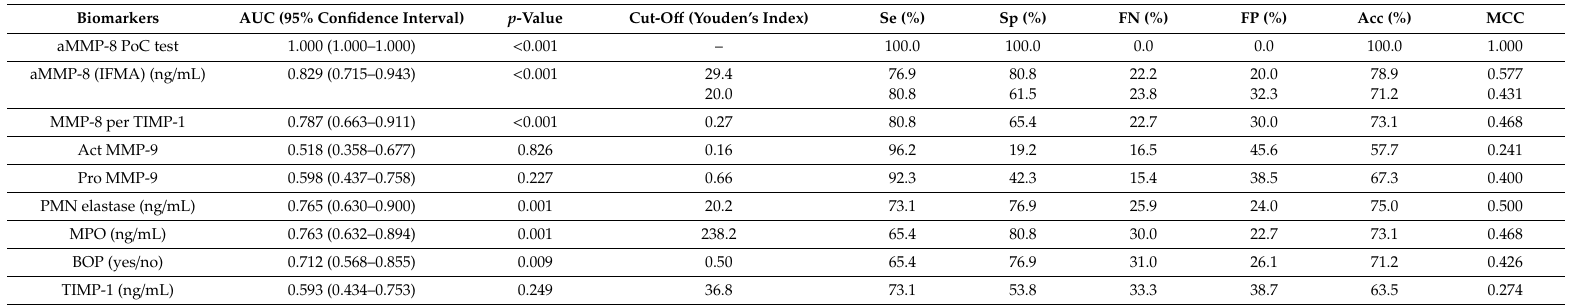
Table 3. Receiver operating characteristic (ROC) analysis and the area under the ROC curve (AUC) illustrating the diagnostic ability of the biomarker candidates to discriminate peri-implantitis from a healthy implant (26 peri-implant and 26 healthy dental implant patients). The Youden index was used defining the best cut-o ff s from the ROC curves of biomarkers. Diagnostic sensitivity (Se), specificity (Sp), the percentage of false negatives (FN) and false positives (FP), test accuracy (Acc), and Matthews correlation coe ffi cient (MCC) were calculated for the biomarkers using the best cut-o ff